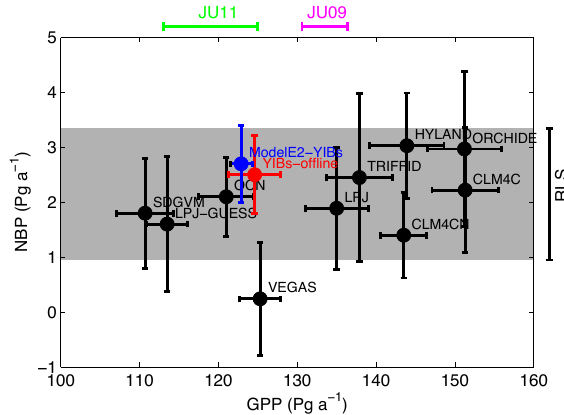
Figure 7. Comparison of simulated global GPP and net biome pro- ductivity (NBP) from (red) YIBs-offline and (blue) ModelE2-YIBs models with 10 other carbon cycle models for 1982–2008. Each black symbol represents an independent model as summarized in Piao et al. (2013). Error bars indicate the standard deviations for in- terannual variability. The gray shading represents the global resid- ual land sink (RLS) calculated in Friedlingstein et al. (2010). The green line at the top represents the range of GPP for 1982–2008 es- timated by Jung et al. (2011) and the magenta line represents GPP for 1982–2011 from Jung et al.